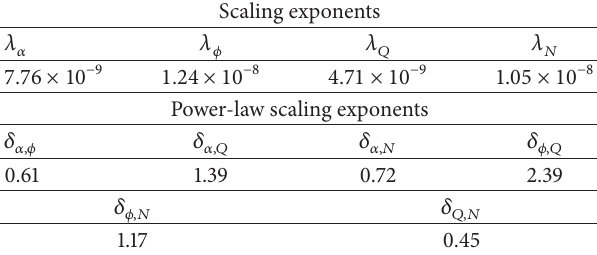
Table 1: This table outlines the various scaling exponents that were derived in (9) and (11) and their respective magnitudes as calculated from the data in Figures 2 and